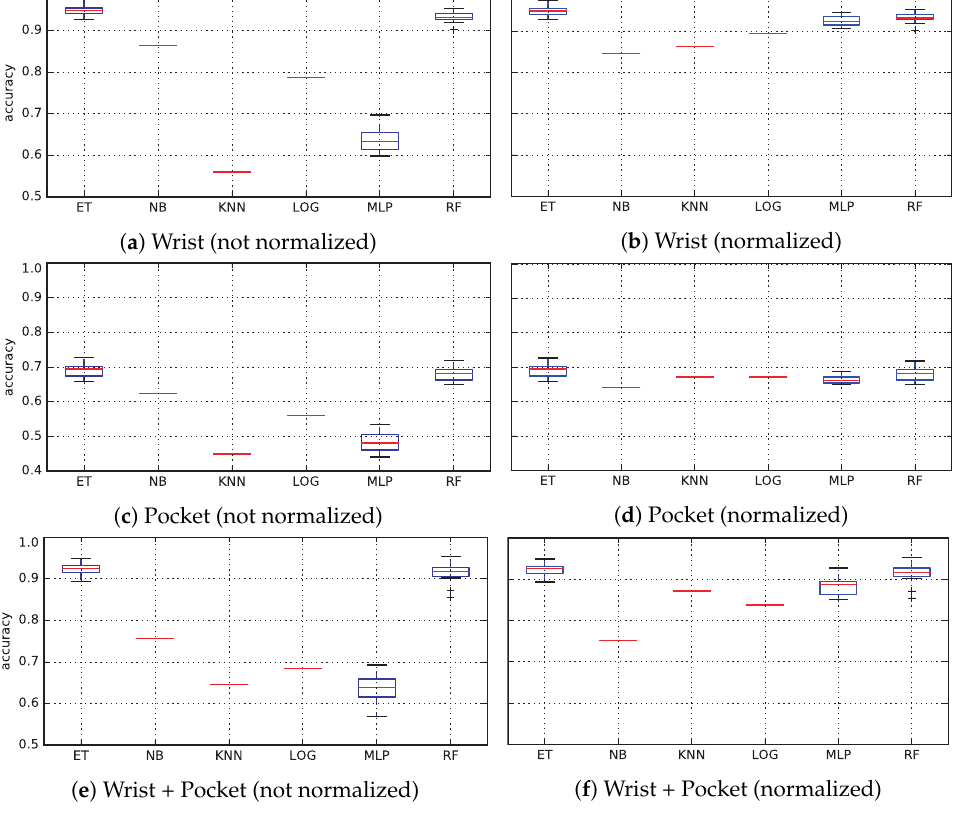
Figure 9. Accuracy for the six classical classifiers for the three datasets, both for not normalized data ( left ) and for normalized data ( right